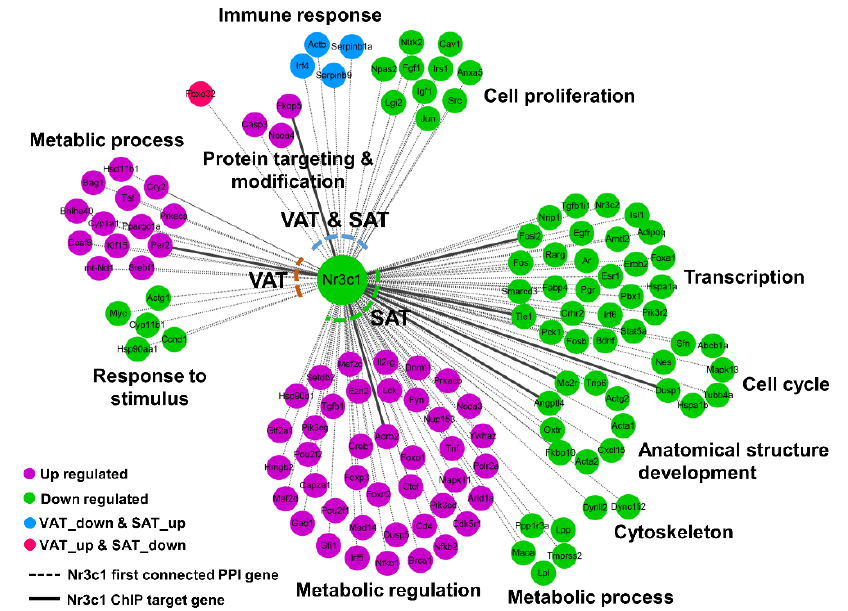
Figure 4. Integrated network analysis of Nr3c1 first connected the DEGs in both VAT and SAT. 2.6. ADX, but Not OVX, Exerts Great Effects on the Intrinsic Difference between SAT and VAT inflammation in response to obesity [33–36]. The pairwise comparison revealed 4171 DEGs between VAT and SAT in the sham control female mice, of which 1909 (45.77%) were upreg- ulated and 2262 (54.23%) were downregulated in VAT compared to SAT (Figure 2B). The functional enrichment analysis indicated that the VAT-enriched genes (i.e., the upregulated DEGs in VAT) were mainly annotated into the BP of the lipid metabolic process, angio- genesis and cell death, into the CC of the mitochondrion, peroxisome and